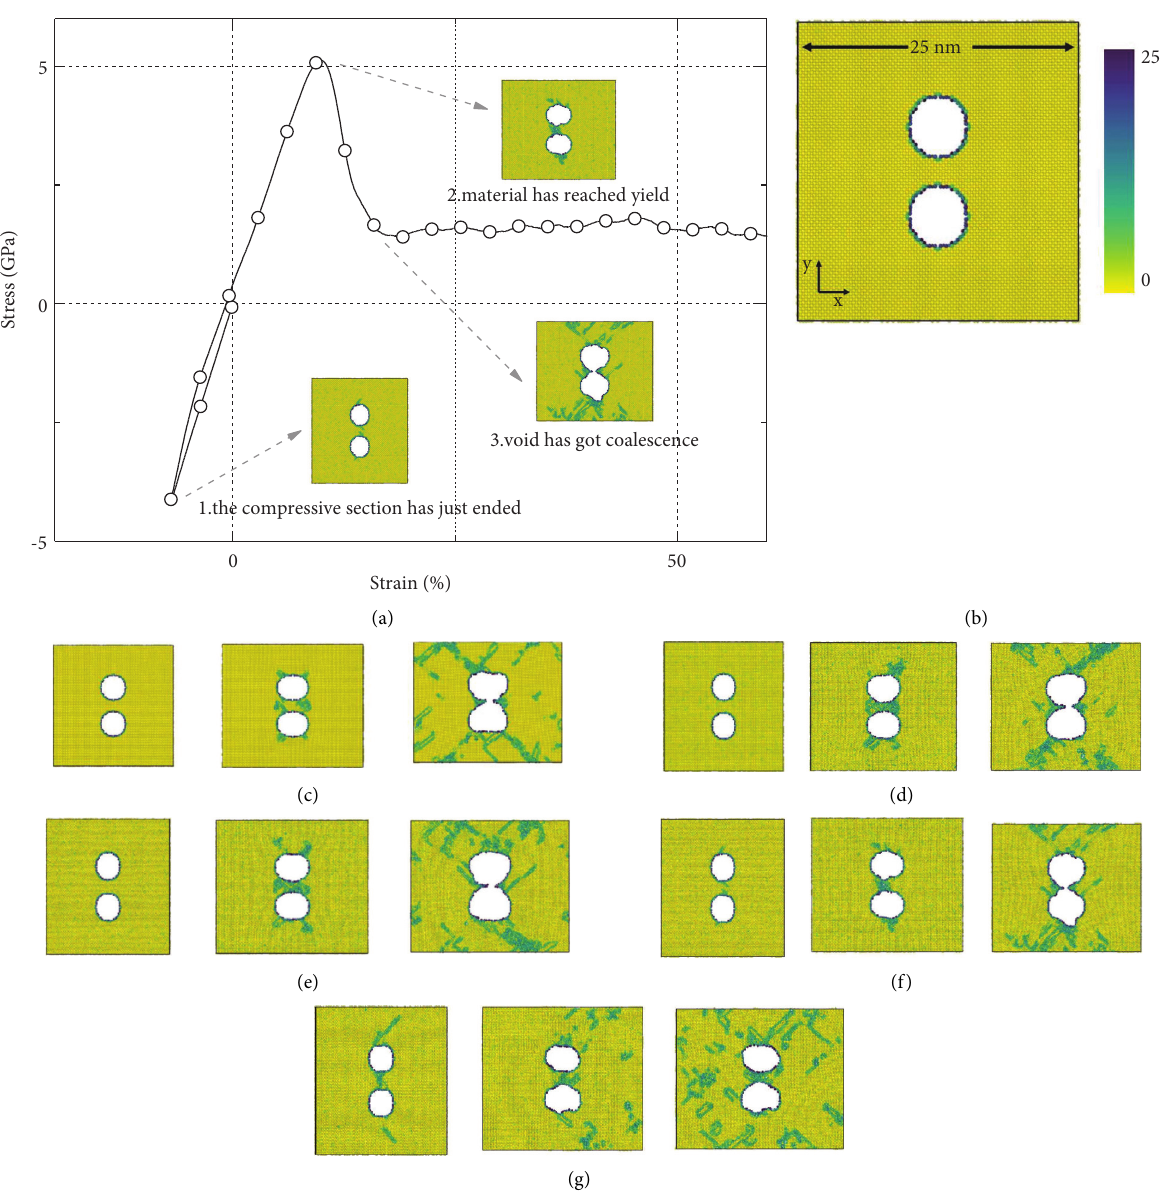
Figure 3: (a) Three moments as the analysis objectives; (b) the snapshot of section view; (c–f) the atomic snapshot of different compressive strains at the “three important moments” shown in Figure 3(a). (a) Three important moments: 1. the compressive section has just ended; 2. the material has reached yield; 3. the void has coalescence. (c) ε ic � 0%. (d) ε ic � − 5%. (e) ε ic � − 6%. (f) ε ic � − 7%. (g) ε ic � −